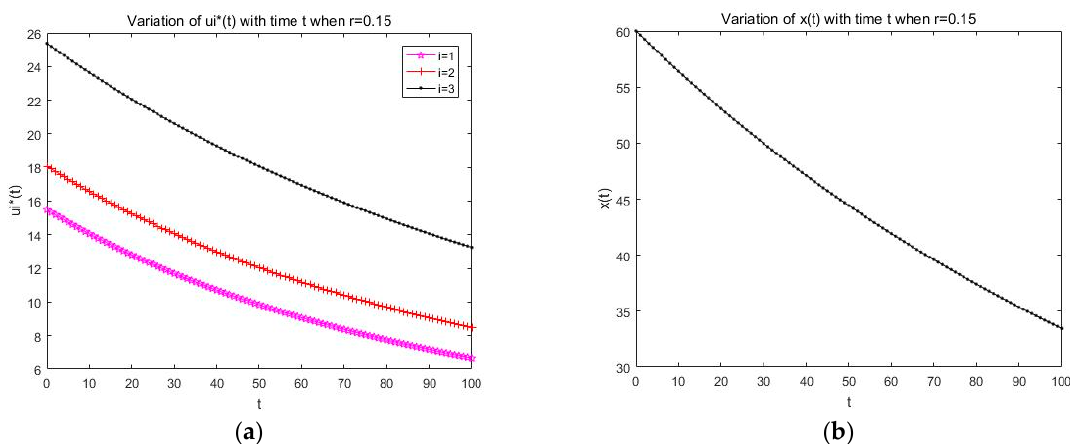
Figure 4. ( a ) Variation of 𝑢 (cid:3036)∗ (𝑡) with time t for the feedback solution; ( b ) variation of 𝑥(𝑡) with time t for the feedback solution.